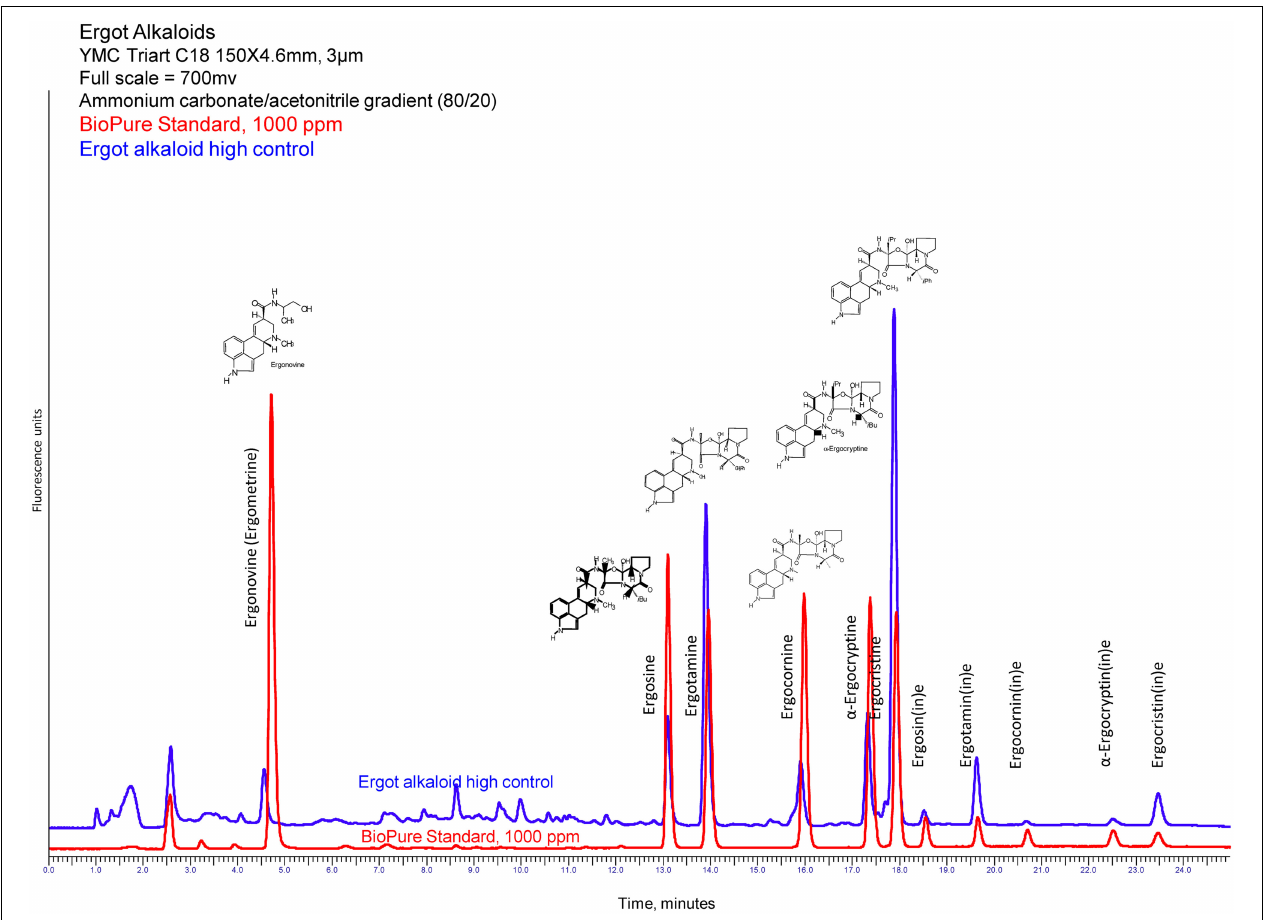
FIGURE 1 | HPLC fluorescence chromatogram of ergot alkaloids, both pure standards and extracted feed sample containing ergot bodies (Craig et al.,